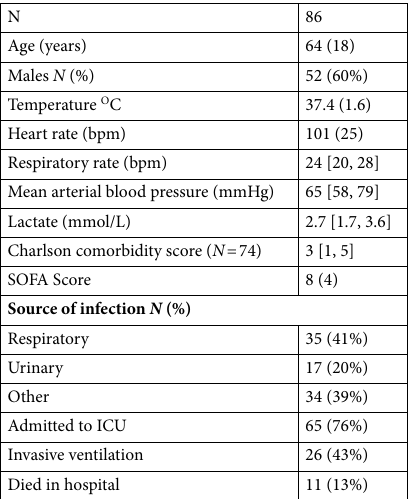
Table 1. Participant characteristics. Values are n (%), mean (sd) or median [first to third quartile: Q1, Q3]. SOFA Sequential Organ Failure